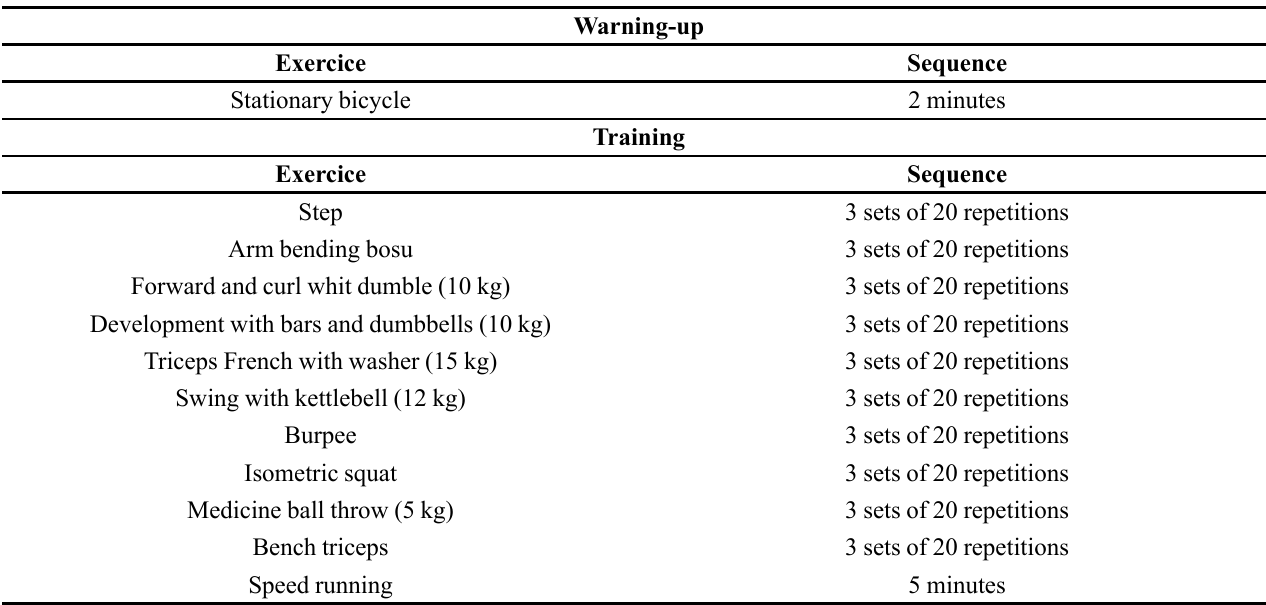
TABLE I – Training protocol